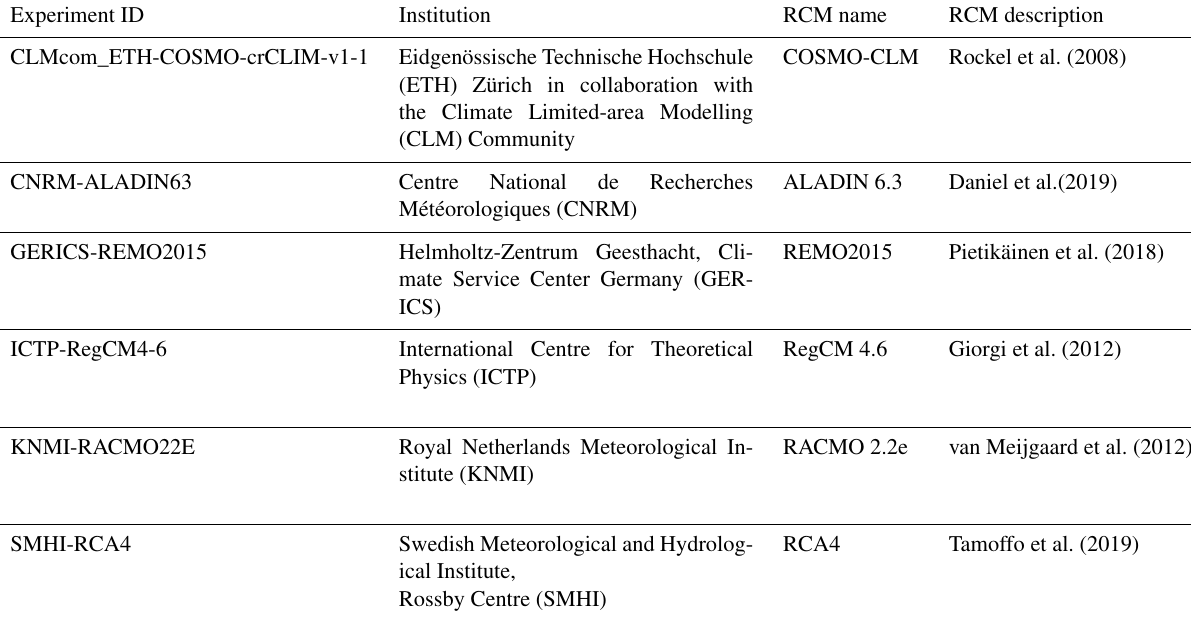
Table 1. Overview of the EURO-CORDEX RCMs used in this study. Experiment